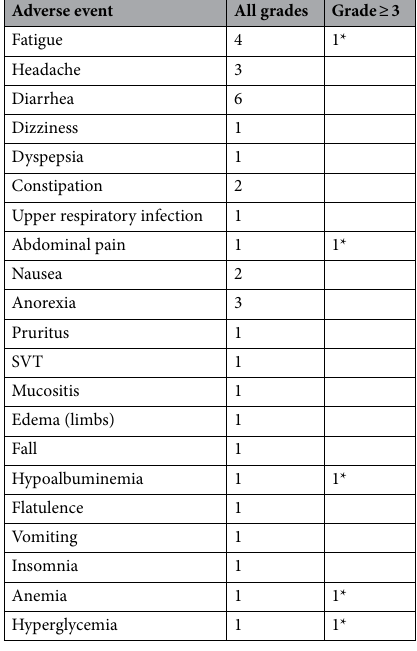
Table 2. Summary of adverse events. *AE was deemed Grade 3.